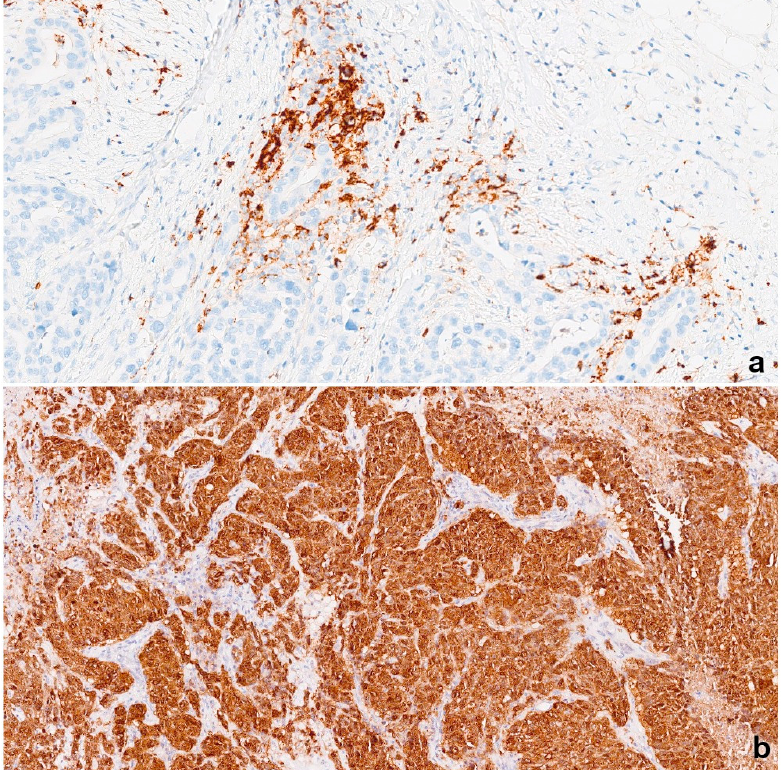
Figure 1. ( a ) Strong punctate and granular cytoplasmatic staining of intratumoral lymphocytes by Ventana SP142 assay. PD-L1 expression was considered positive if staining of any intensity was noted in tumor-infiltrating immune cells covering ≥ 1% of the tumor area occupied by tumor cells, the associated intratumoral region, and contiguous peritumoral stroma. ( b ) Strong cytoplasmic immunohistochemical staining of NY-ESO-1 in tumor cells. NY-ESO-1 expression was considered positive if ≥ 1% of tumor cells showed cytoplasmic and/or nuclear positivity.